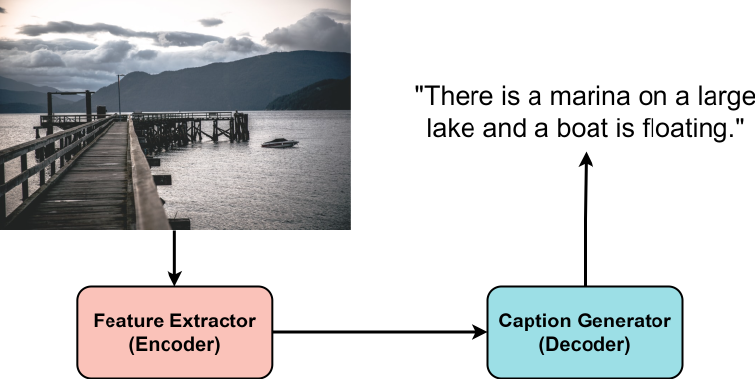
Figure 1. Typical image caption architecture. It consists of image feature extractor (encoder) and caption generator